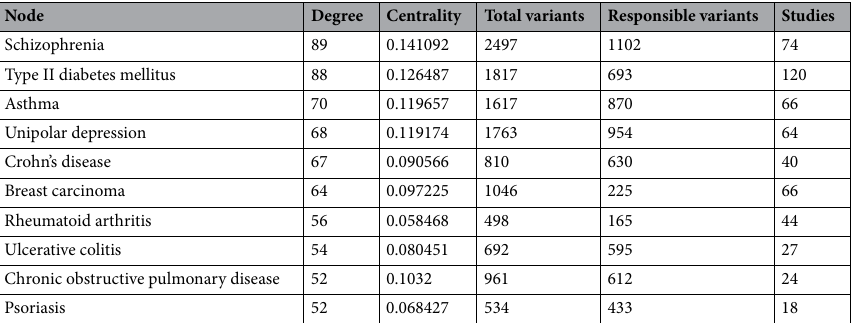
Node Degree Centrality Total variants Responsible variants